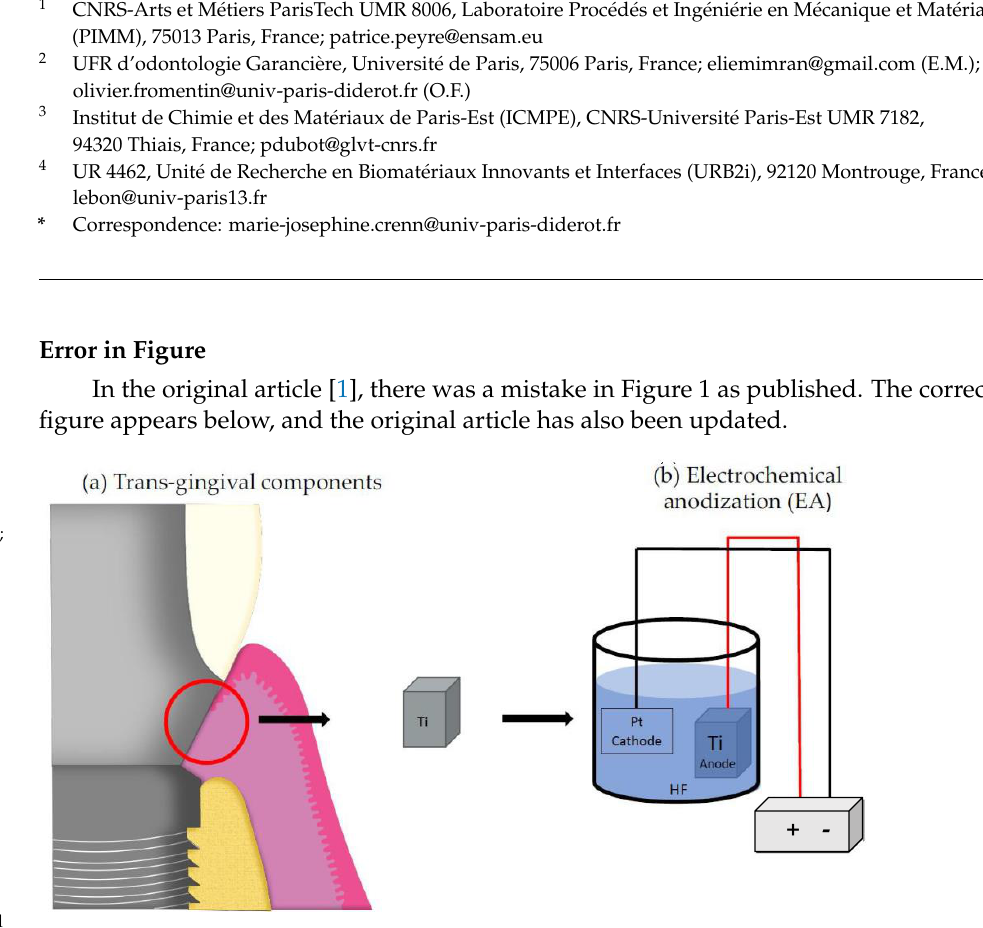
Figure 1. Schematic representation of ( a ) the trans-gingival abutment–mucosa interface and ( b ) the electrochemical anodization step to fabricate TiO 2 nanotubes or nanopores. Reference 1. Crenn, M.-J.; Dubot, P.; Mimran, E.; Fromentin, O.; Lebon, N.; Peyre, P. Influence of Anodized Titanium Surfaces on the Behavior of Gingival Cells in Contact with: A Systematic Review of